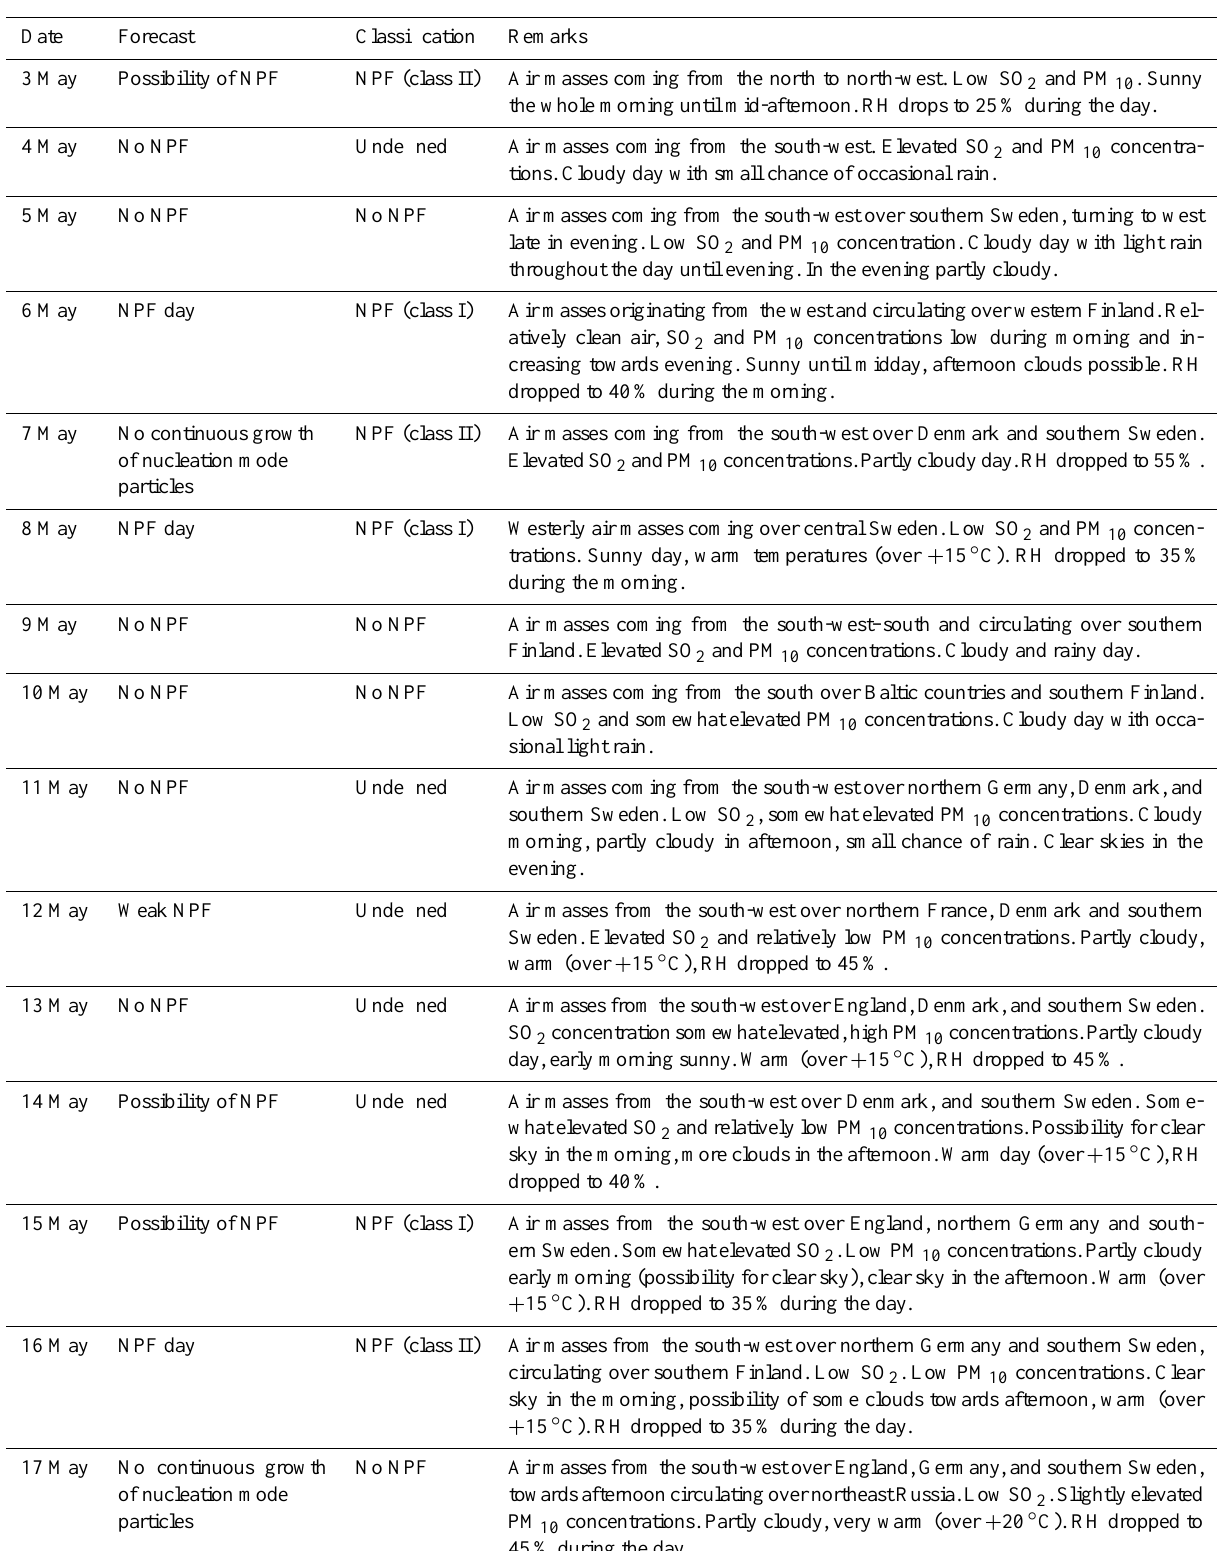
Table 3. NPF event forecasts (second column), and NPF event classification based on measured particle size distributions (third column) for each day of the campaign. Class I and II NPF events refer to the classification by Dal Maso et al. (2005). Remarks on the fourth column show the basis for the NPF event